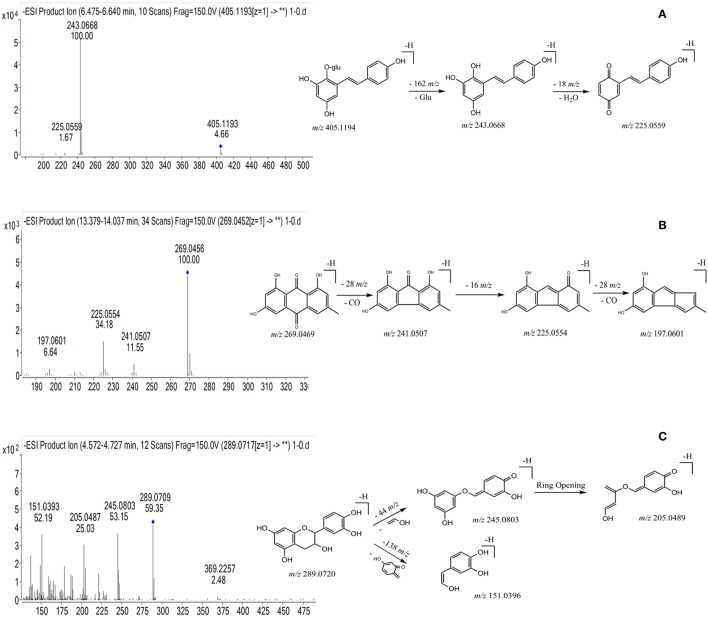
The chemical structure, typical mass spectra and proposed fragmentation pathways of three types of chemical components from PMR. (A) THSG; (B) emodin; (C) catechin.